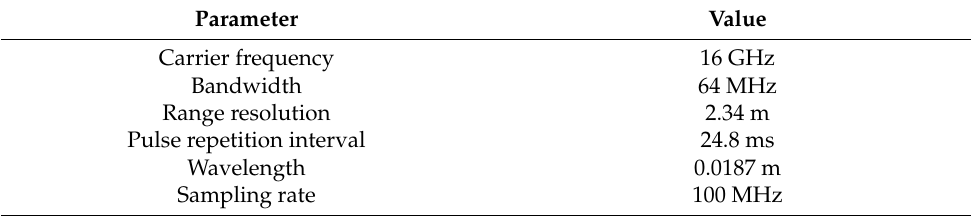
Table 5. Parameters of real radar.